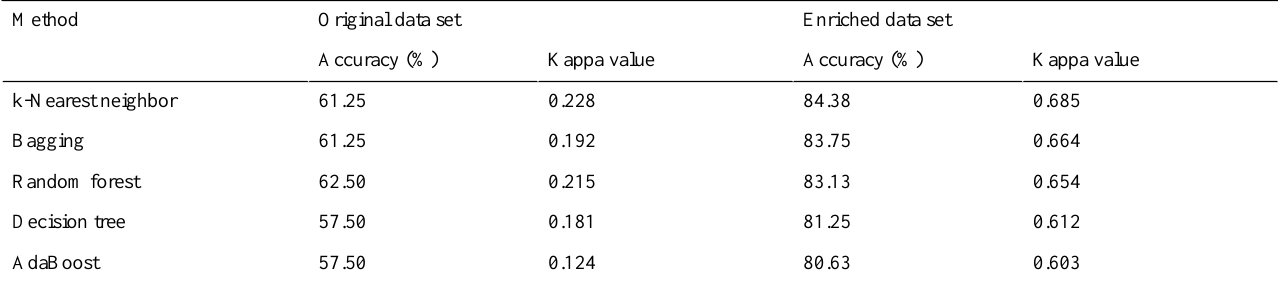
Table 1. Accuracies and kappa values of models before and after data enrichment.